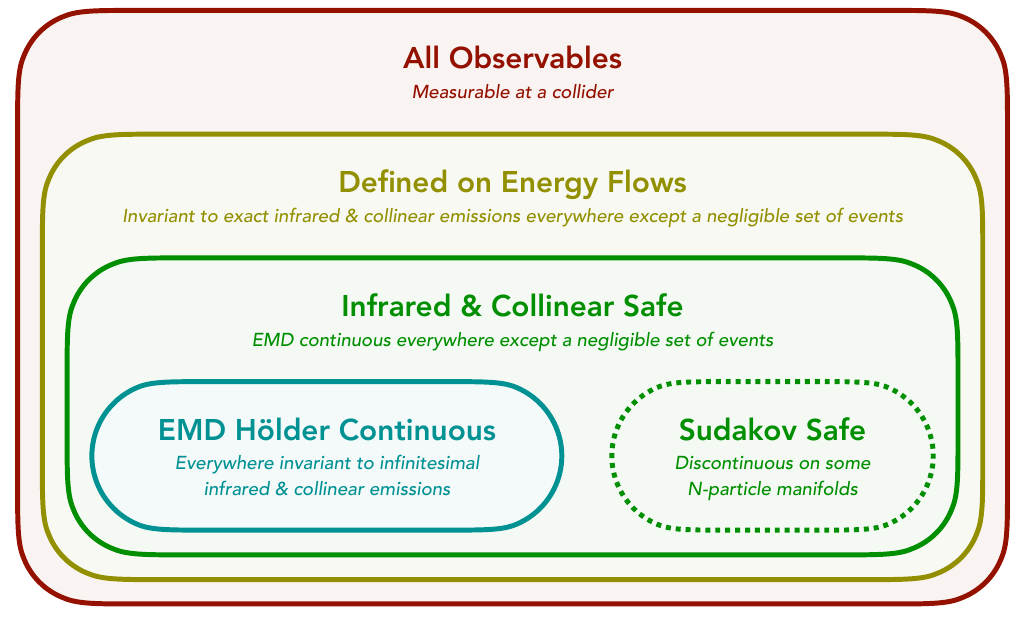
Figure 2 . An illustration of the set of observables partitioned according to various IRC-invariance properties. Examples of observables in each category are listed in table